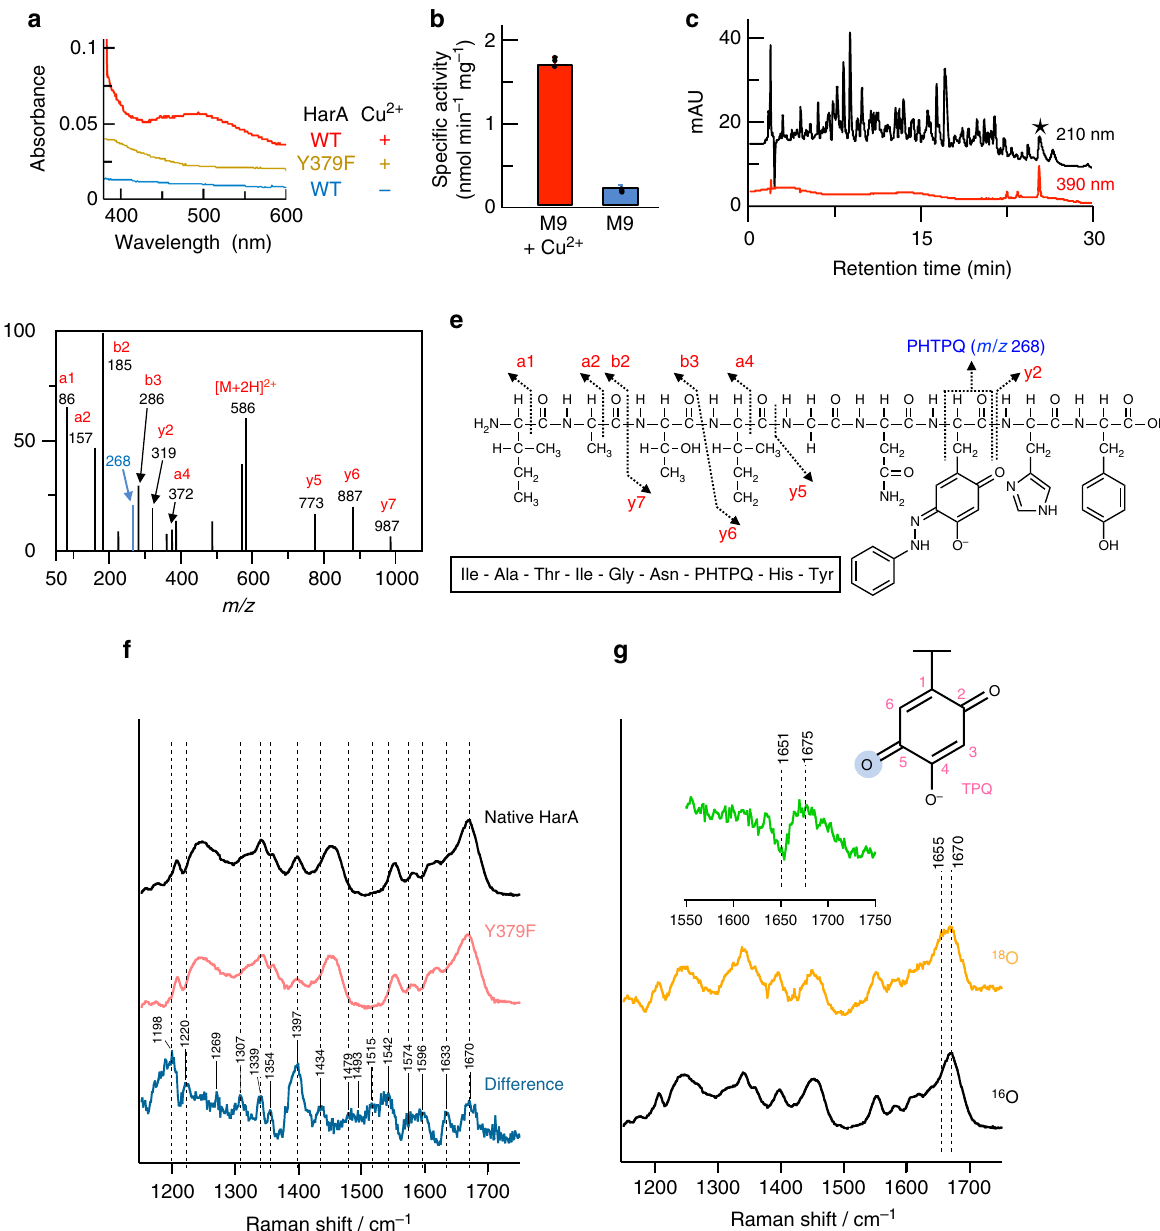
Fig. 3 Post-translationally-synthesized cofactor topaquinone of HarA. Topaquinone (TPQ) within HarA was post-translationally synthesized from a speci fi c tyrosine residue of HarA in the presence of copper ion and involved in HarA-catalyzed harmaline degradation. a Wild-type HarA and the Y379F mutant were expressed in E. coli in M9 medium with or without supplementation of 5 μ M CuSO 4 . UV-vis spectra of the puri fi ed enzymes are shown. b Speci fi c activities of wild-type HarA expressed in E. coli in M9 medium with or without supplementation of 5 μ M CuSO 4 . All data points represent the mean values ± S.D. for three experiments. Source data are provided as a Source Data fi le. c Phenylhydrazine-treated HarA was digested with chymotrypsin, and then analyzed by LC/MS. The nonapeptide that was labeled with phenylhydrazine is denoted as a black star. d The above nonapeptide was then analyzed by LCMS/MS. e The fragment that exhibited a m/z value of 268 corresponds to that of a fragment containing the pheynylhydrazine-TPQ adduct (PHTPQ). f Raman spectra of native HarA and the Y379F mutant, and their difference (native HarA − Y379F). The concentration of each enzyme was 2 mM. g HarA was incubated in 94% H 2 18 O for 2 days at 4 °C. Inset: Their difference ( 16 O − 18 O)